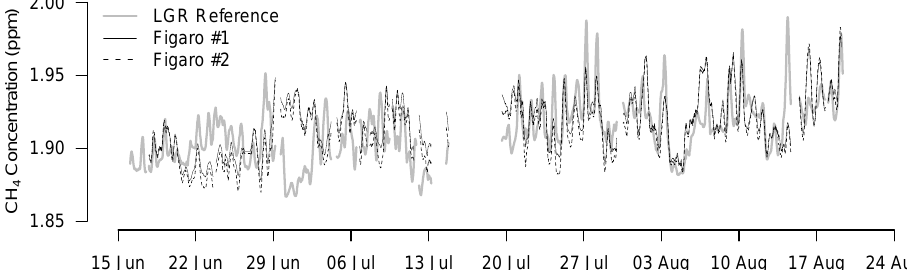
Fig. 4. Seasonal course of CH 4 concentration measurements over Toolik Lake during the ice-free season 2011. Data from all sensors where smoothed with a 6-h boxcar moving average.